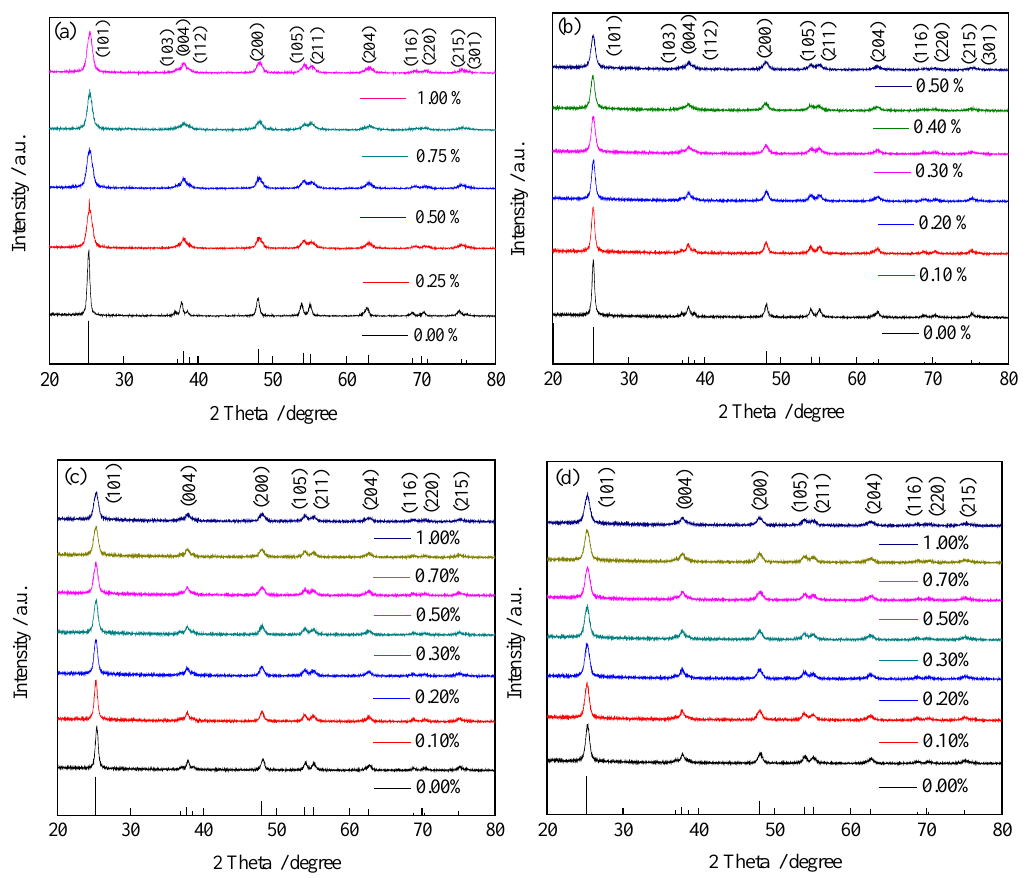
Figure 2. X-ray diffraction (XRD) patterns of RE/TiO 2 samples. ( a ) La/TiO 2 (500 °C); ( b ) Ce/TiO 2 (500 °C); ( c ) Gd/TiO 2 (500 °C); ( d ) Yb/TiO 2 (450 °C).